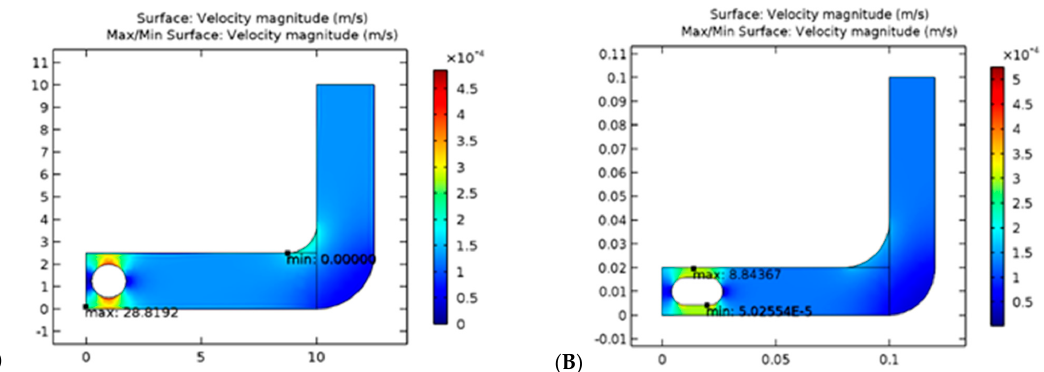
Figure 2. Comparison of velocity for spherical ( A ) and capsule ( B ) geometries in the GI tract. The pressure exerted on each shape was additionally analyzed. Figure 3